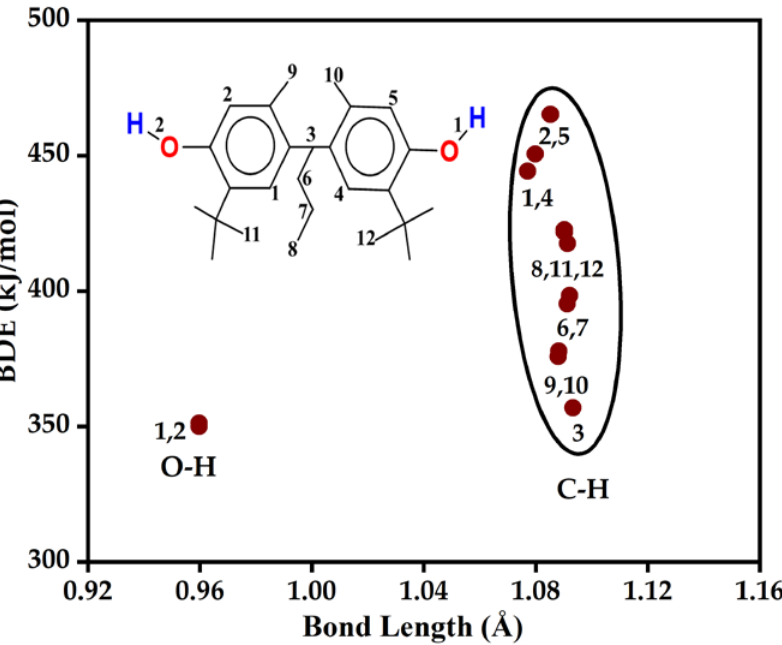
Figure 5. Bond dissociation enthalpy (BDE) vs. bond length plot for Santowhite (SW). Calculations have been carried out at the M06-2X/6-311++G(2d,2p) level of theory in gas phase. The numbers represent the X-H (X = C, H) bonds in the structure.